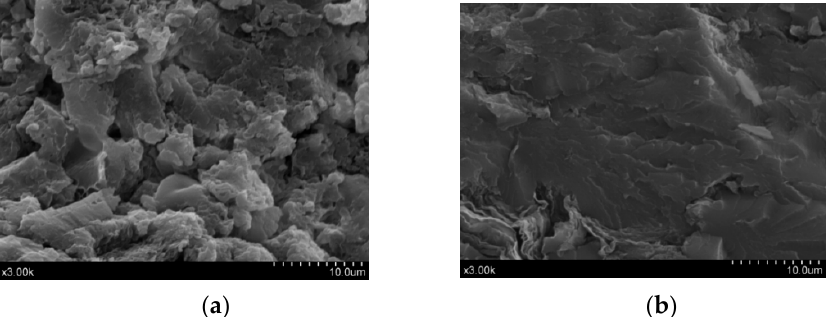
Figure 5. The electrical conductivity of Graphene/PEKK bar distribution on the different height.